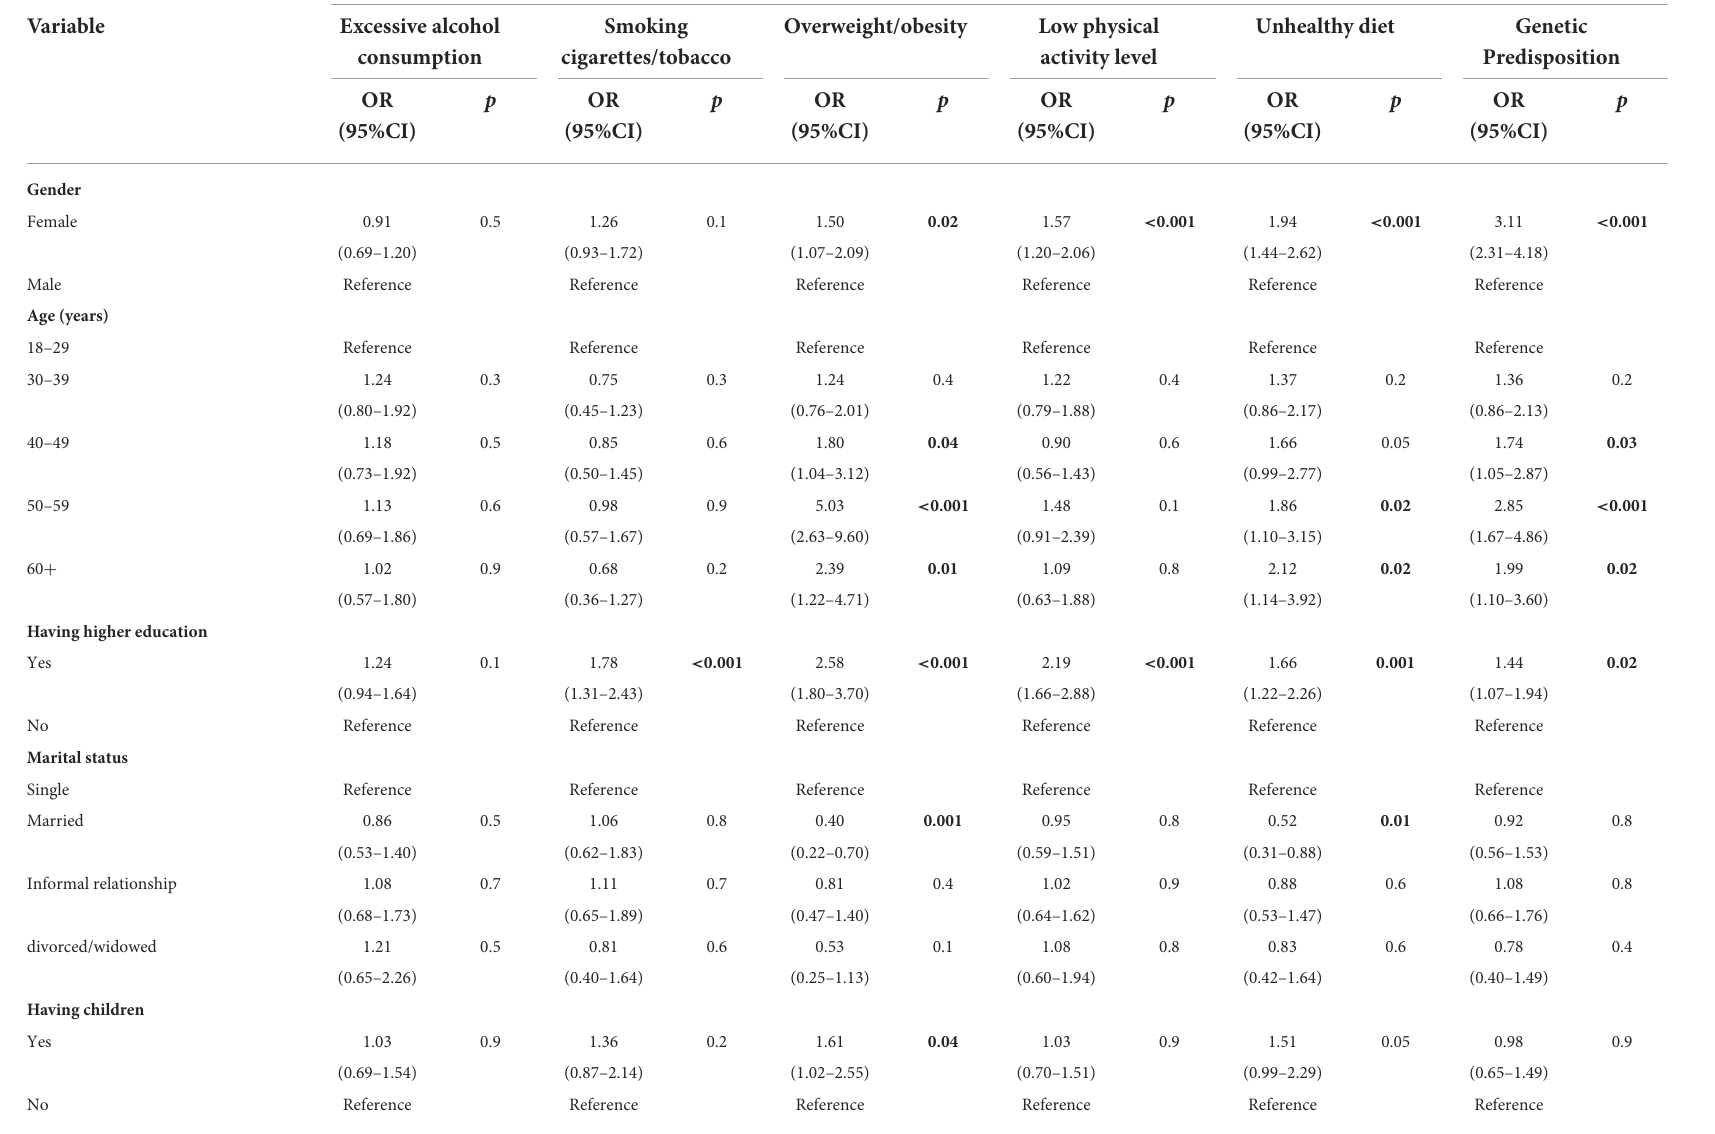
TABLE 8 Factors associated with awareness of risk factors for diabetes among adults in Poland ( n = 1,051)—multivariable logistic regression model. Factors associated with awareness of risk factors for diabetes among adults in